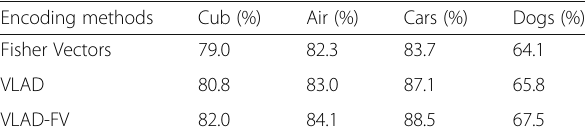
Table 1 Comparison of performance of Fisher Vectors, VLAD, and VLAD-FV Encoding methods